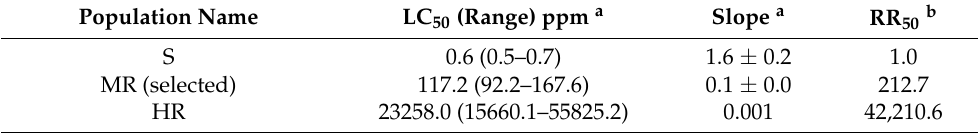
Table 2. Onion thrip populations used in this study and their susceptibility to spinosad.